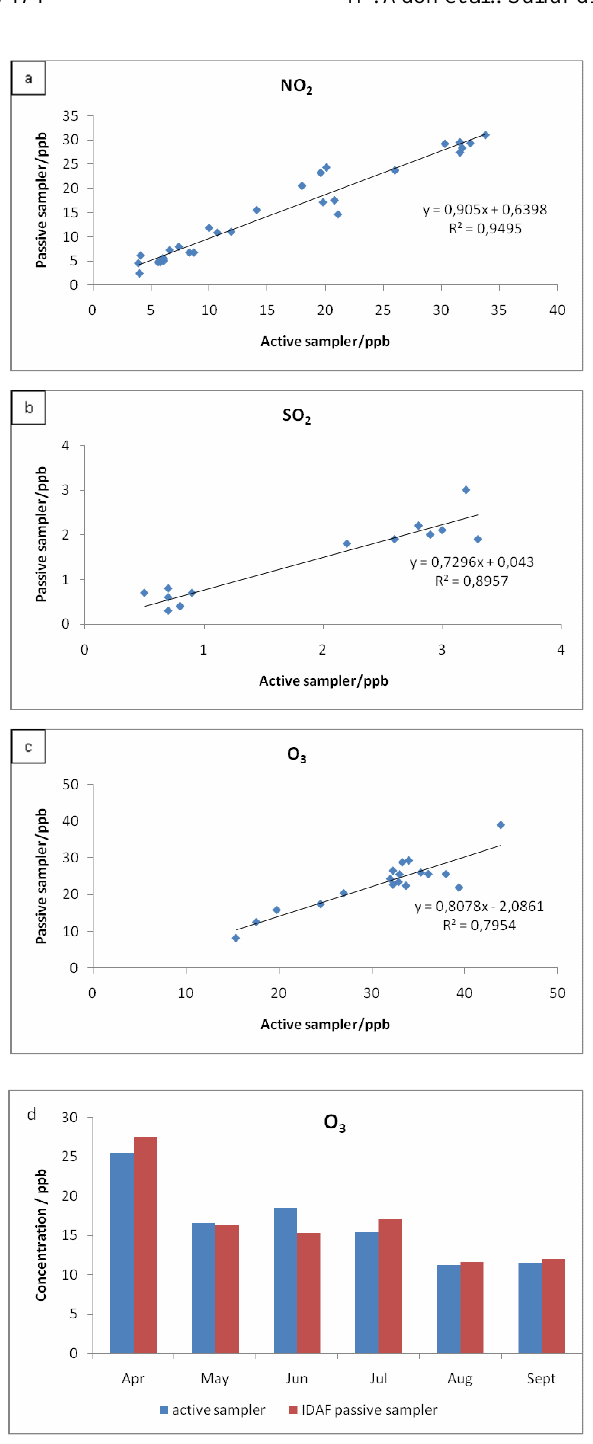
Figure 3 : Comparison of active and passive NO 2 (3a), SO 2 (3b), O 3 (3c) measurements (ppb) at Fig. 3. Comparison of active and passive NO 2 (a) , SO 2 (b) , O 3 (c) Toulouse (France) from 1998 to 2000, O 3 (3d) measurements at Djougou (Benin) in 2006. measurements (ppb) at Toulouse (France) from 1998 to 2000; O 3